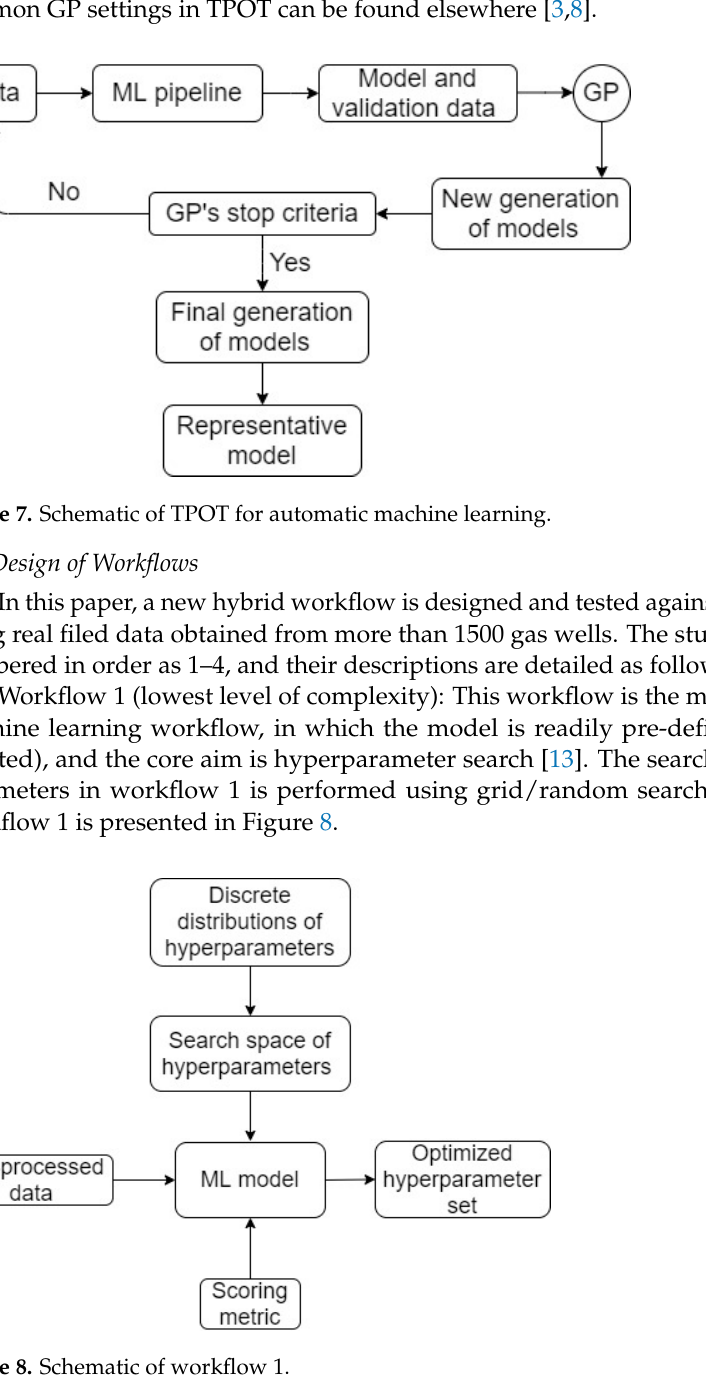
Figure 6. Schematic of a ML pipeline in TPOT.